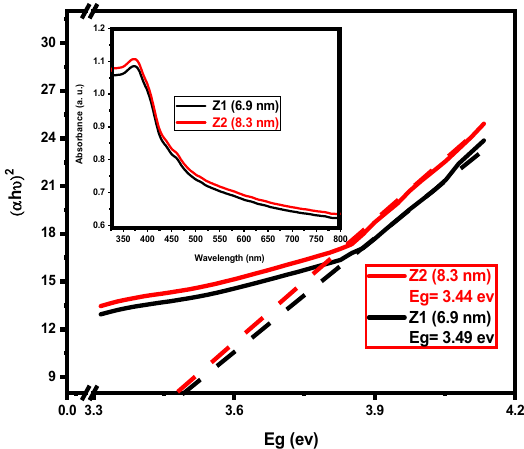
Figure 3. UV-Visible absorption spectra and estimation bandgap energies of ZQDs. The inner image is the absorption spectrum of Z1 and Z2 samples. Bandgap energy values are estimated as 3.49 and 3.44 eV for Z1 and Z2 samples, respectively, which are clearly higher than ZnO bulk (3.37 eV) [2,41]. The correlation between BET, Eg, and ZQDs samples is represented in Figure 4; based on the particle size of the prepared samples, the BET values are directly commensurate with the band gap energy and inversely commensurate with the crystallite sizes of the photocatalyst prepared.